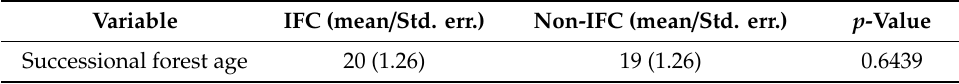
Table A4. Analysis of variance of successional forest age between IFC and Non-IFC landscapes. Variable